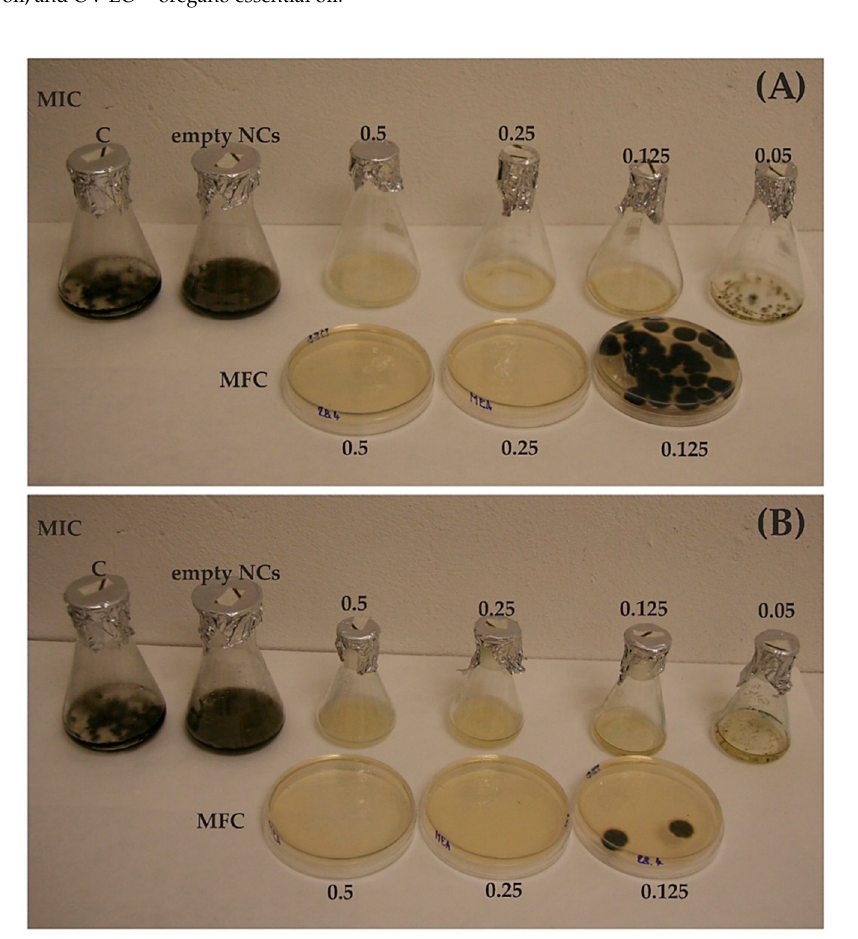
Figure 2. Example of MIC and MFC assays with the isolate Cladosporium herbarum . ( A ) Results